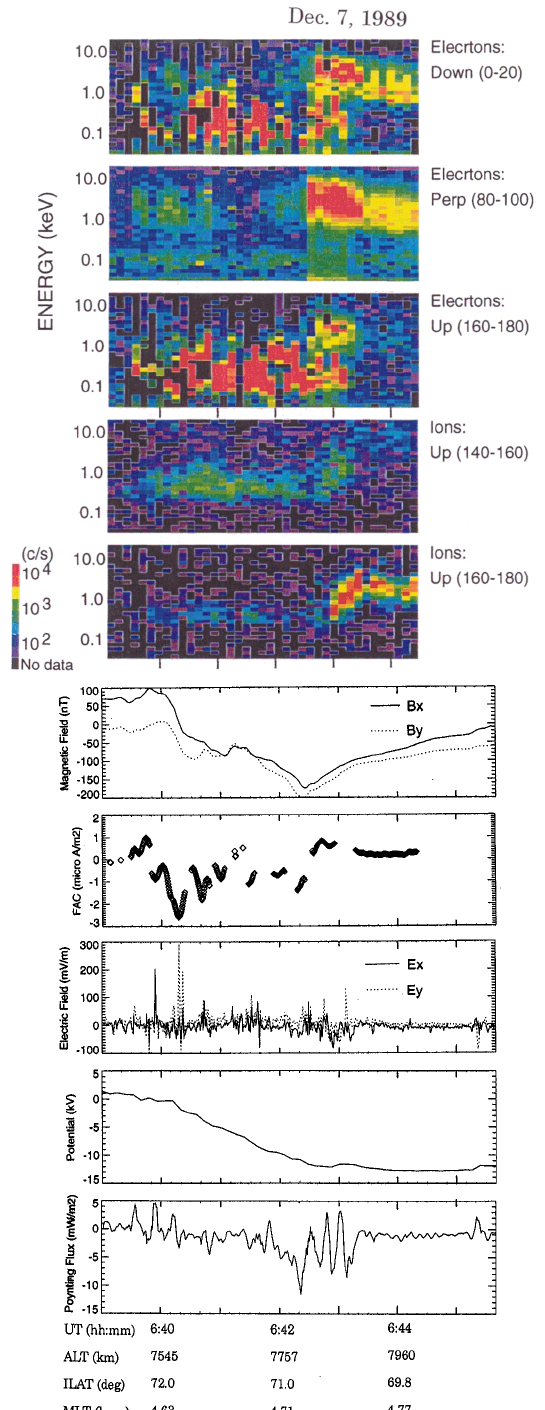
Fig. 1. Overview of a field-aligned electron event observed with Akebono on 7 December 1989. From top to bottom: Energy- time diagrams of downgoing (pitch angle of 0–20 ◦ ), perpendicu- lar (80–100 ◦ ), and upgoing (160–180 ◦ ) electrons, and of upgoing (140–160 ◦ and 160–180 ◦ ) ions. Two components of magnetic field. Field-aligned current derived from the magnetic field observation. Two components of electric field. Electric potential calculated by the integration of the observed electric field along the satellite path. Poynting flux along the geomagnetic field line.